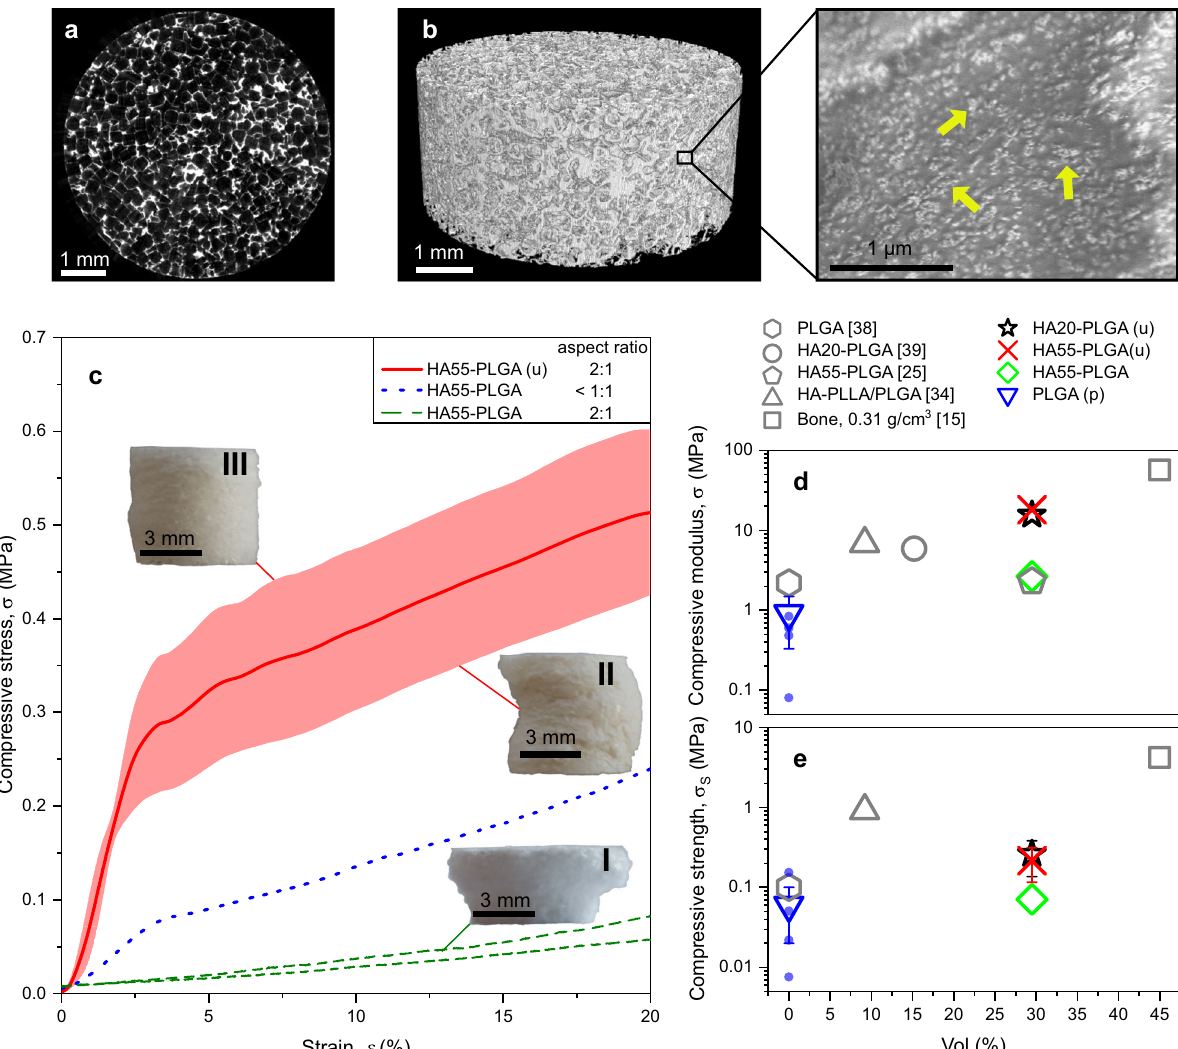
Fig. 1 Reinforced polymer nanocomposite bone scaffold properties. a Micro-CT raw image of a cross-sectional slice of a representative HA55-PLGA (u) scaffold. b 3D model obtained from that micro-CT scan, along with a scanning electron microscopy image of the surface, showing hydroxyapatite nanoparticles exposed at the surface (arrows). c The compressive stress as a function of strain of dry and unseeded HA55-PLGA (u) nanocomposite scaffolds with a 2:1 height to diameter aspect ratio (solid red line, n = 5), and scaffolds made by standard SCPL 25 with aspect ratio <1:1 (blue dotted line, n = 1) or 2:1 (green broken lines, n = 2). The red line represents the average and the shaded areas the s.d. The letter u denotes the modi fi ed production method with ultrasonication and pressure molding. Because of the high aspect ratio some scaffolds buckle ( a-II) vs. ( a-III) , resulting in lower compressive strength and variation after 2.5% strain. d Compressive moduli and e strength of bone 15 or dry and unseeded nanocomposite scaffolds of various fi ller speci fi c surface areas as a function of fi ller vol% and similar ones from literature 25,34,38,39 ; all with porosity above 80%. The letter p denotes production by pressure molding. Symbols and error bars of tested samples represent the mean ± s.d.; triangle down n = 4, star n = 5, cross n = 5, diamond n = 1 independent samples. Error bars within the symbols are not limiting standard SCPL to scaffolds with low aspect ratios 37 . The n = 5) or 15.62 ± 2.89 MPa (Fig. S2, n = 5). We compared the scaffold made with an aspect ratio <1:1 (Fig. 1c, blue dotted line, mechanical properties of these dry and unseeded scaffolds n = 1) had a compressive modulus of 2.7 MPa, consistent with (Fig. 1d: cross, star) with published PLGA-based dry bone scaffolds that have porosities larger than 80% to shed light on the in fl uence of fi ller vol%, SSA, and processing. The reference scaffolds were prepared by gas-foaming particulate leaching 25 (pentagon), high-pressure compression molding 34 (triangle-up), SCPL 38 (hexagon), or 3D 39 bioplotted (circle). Without fi ller (triangle down), the mechanical properties were not improved by pressure molding. These pure PLGA scaffolds (triangle down) produced by the modi fi ed SCPL had a compressive modulus similar to the literature 38 (hexagon). The small difference is accounted to the higher molecular weight PLGA employed there 38 . The impact of the modi fi ed SCPL on the compressive